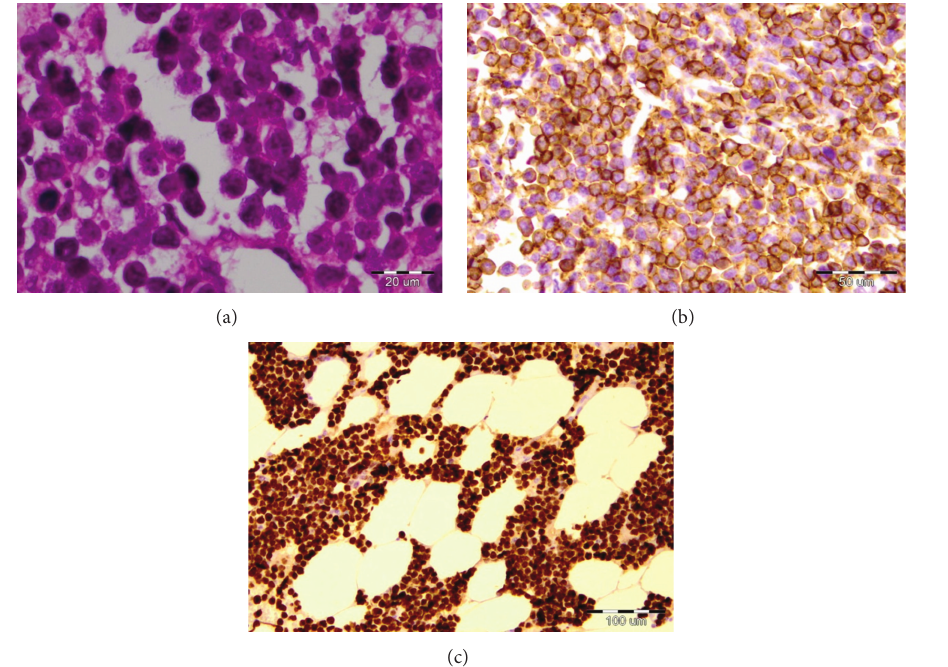
Figure 4: Histological features from peritoneal and omental biopsies. H&E stain: (a) diffuse infiltration of neoplastic lymphoid cells (400x). (b) Tumor cells immunoreactive for B cell marker CD 20 (200x). (c) Tumor cells expressing high Ki-67 index